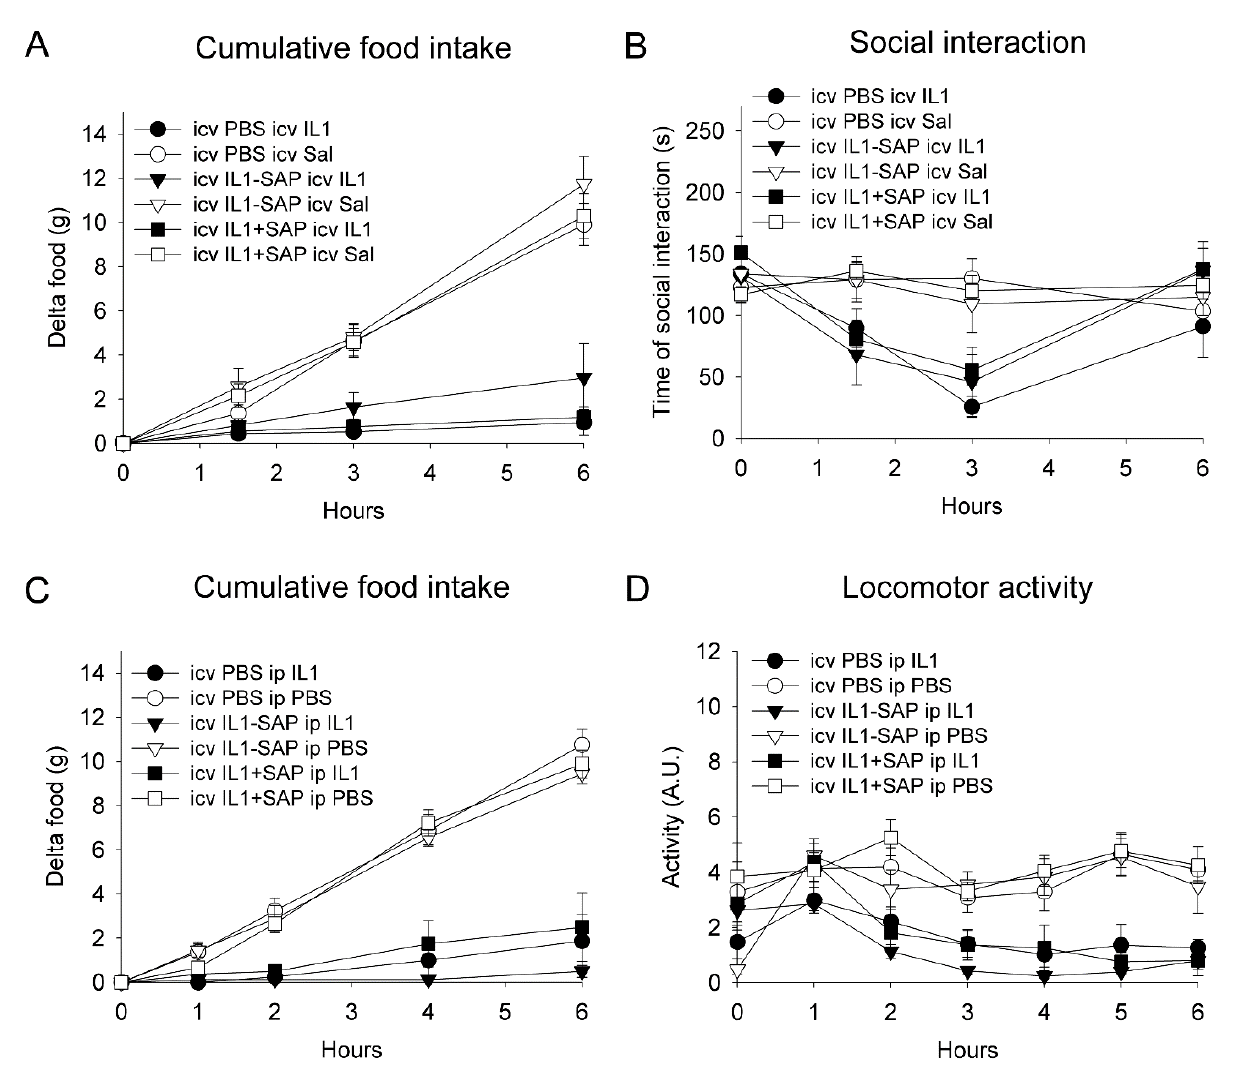
Figure 2. Effects of intracerebroventricular IL-1ß-saporin conjugate administration on subsequent IL-1β-induced sickness behavior. Intracerebroventricular pre-treatment with IL-1β-saporin conjugate did not affect the reduction in food intake and social interaction after intracerebroventricular IL-1ß administration ( A , B ). Intracerebroventricular administration of IL-1β-saporin conjugate did not affect the reduction in food intake and locomotor activity to subsequent intraperitoneal IL-1ß injection ( C , D ). IL1: interleukin-1ß; IL1-SAP: interleukin-1ß conjugated to saporin; IL1 + SAP: interleukin-1ß